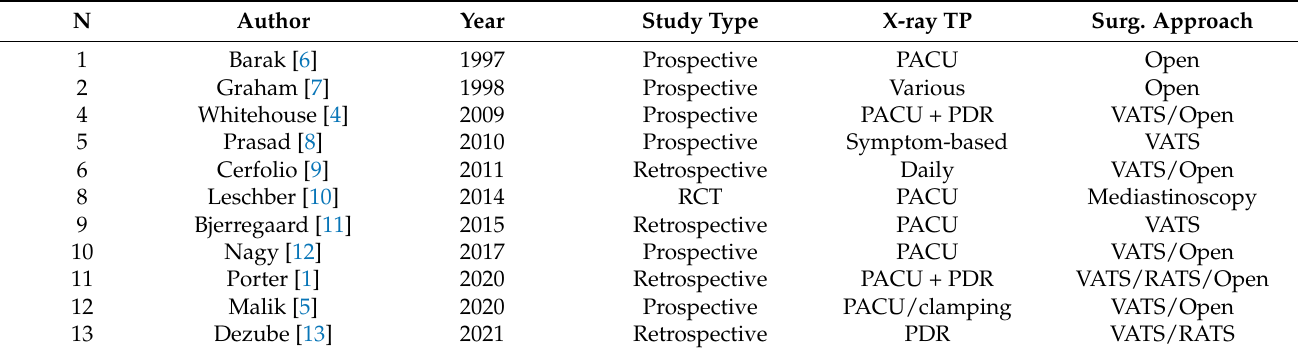
Table 1. Included studies.